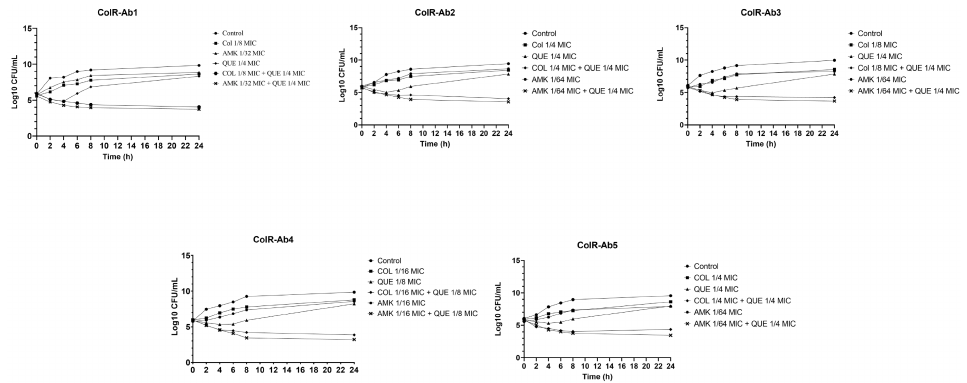
Figure 1. Time-kill curve analysis of all ColR-Ab strains exposed to FIC values of QUE, COL, and AMK, and synergistic concentrations of QUE + COL, and QUE +